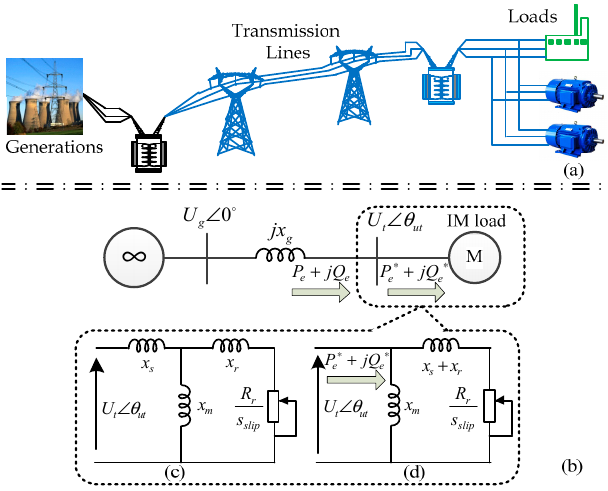
Figure 1. The studied system: ( a ) the physical diagram of the studied system; ( b ) simplified single- induction motor (IM) infinite-bus system; ( c ) IM steady state equivalent circuit; ( d ) simplified IM steady state equivalent circuit.